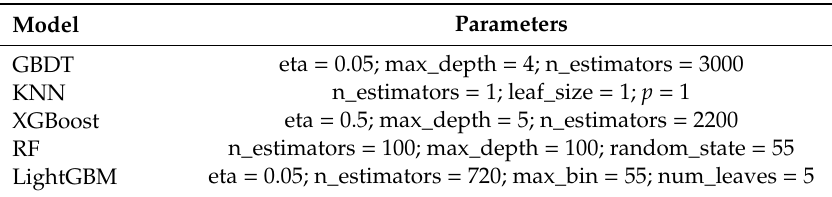
Table 2. Parameters of the five models.